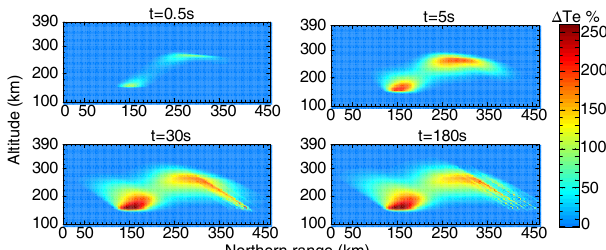
Figure 6. The evolution of the ionospheric electron density changes in the center meridian plane with heating wave incidence perpendic- ular to the magnetic field line at different heating duration times. t=0.5s